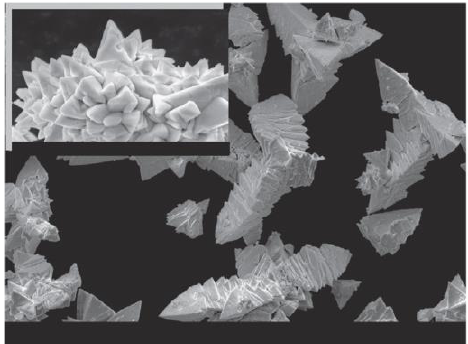
Figure 28. Iron Selenite powder crystals [91].